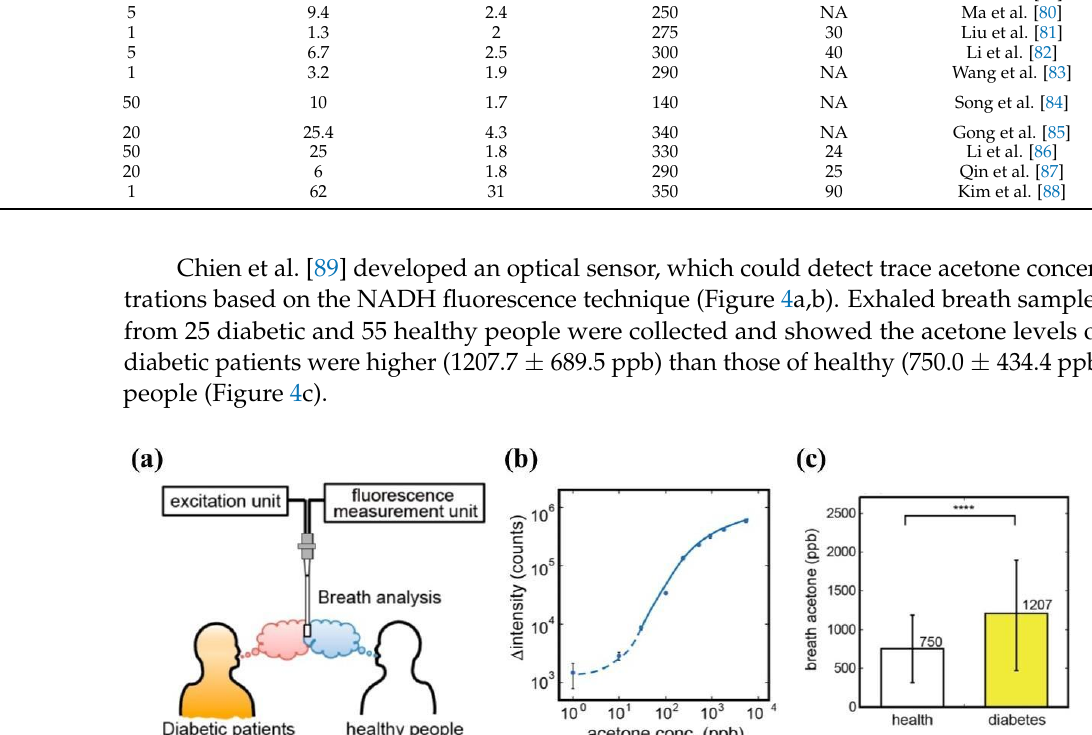
Figure 5. ( a ) Schematic of measurement system of exhaled breath analysis, ( b ) complete system pho ‐ tographs, ( c ) porous material based on 2,6 ‐ diphenylene oxide polymer is filled inside the desorption tubes, ( d ) and a delivery unit Reprinted with permission from [91] Copyright 2018 Elsevier.